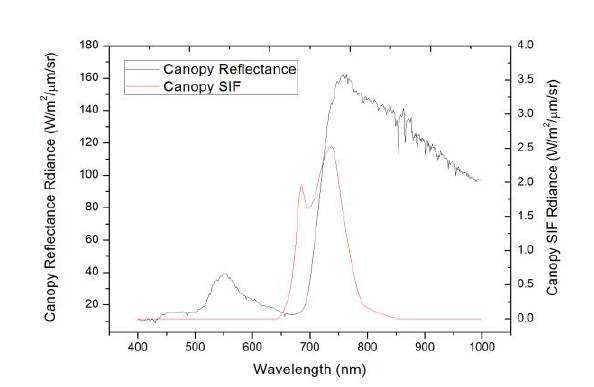
Figure 5. Canopy reflectance and SIF